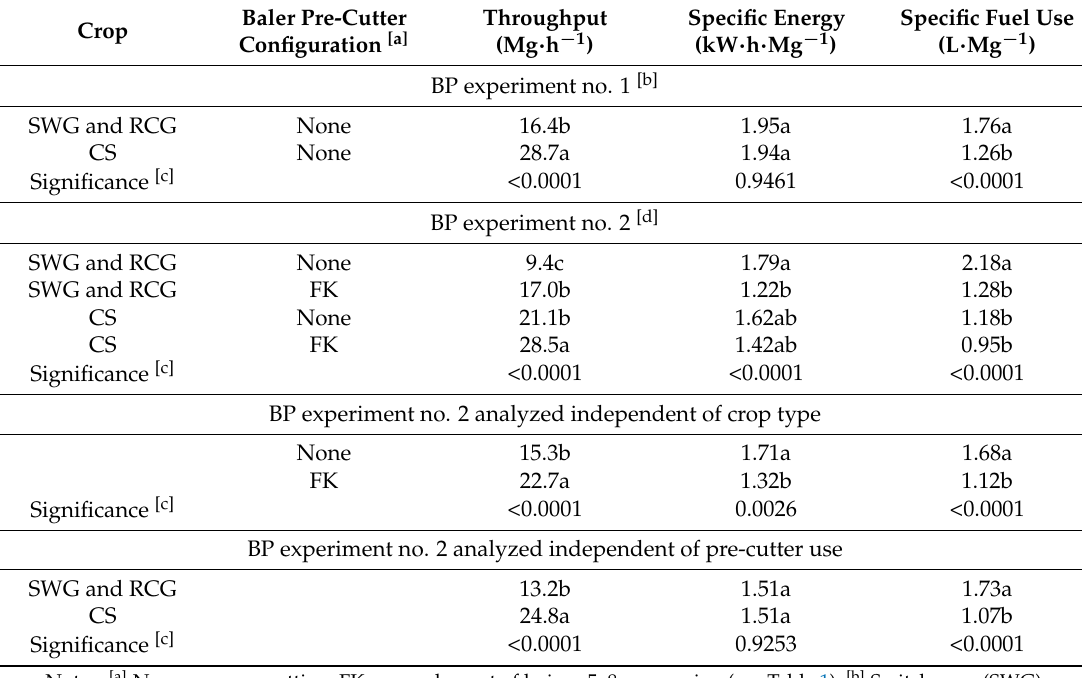
Table 10. Throughput and specific energy requirements (both on a dry basis) for processing large round bales with a bale shredder (BP exprs. nos. 1 and 2, Table